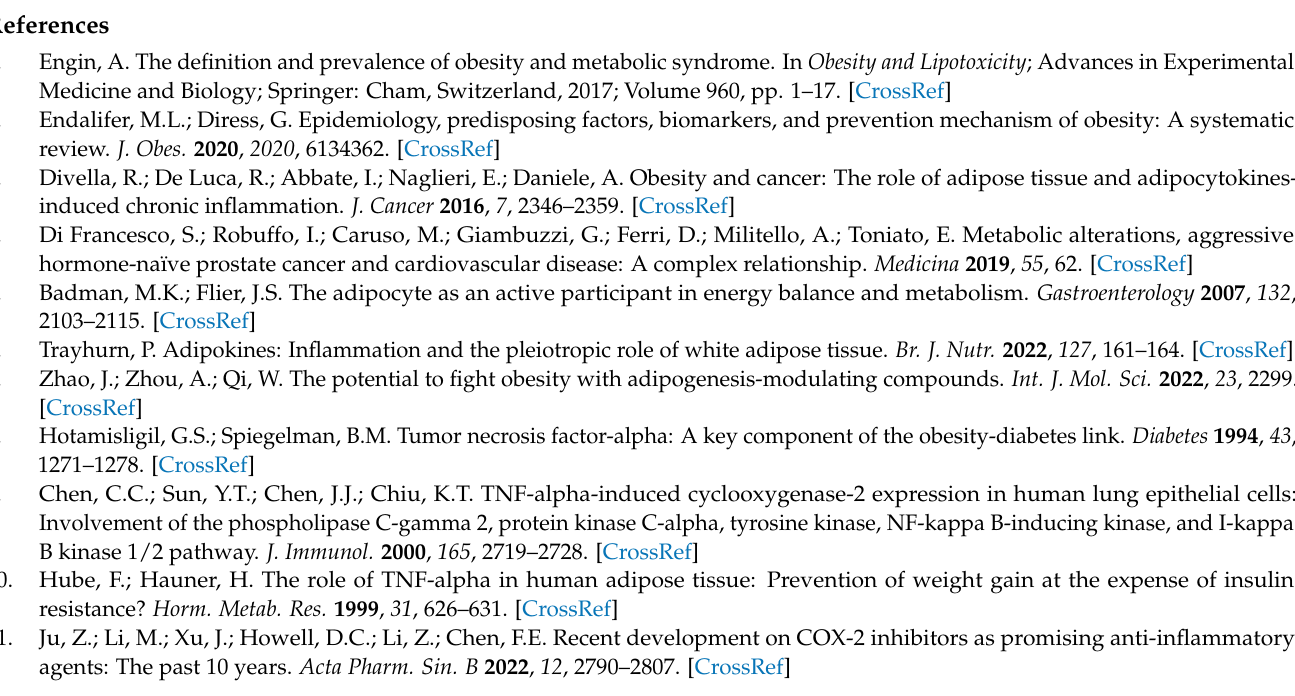
Figure S2: Reduction in adipocyte differentiation by Car in WJ-MSCs